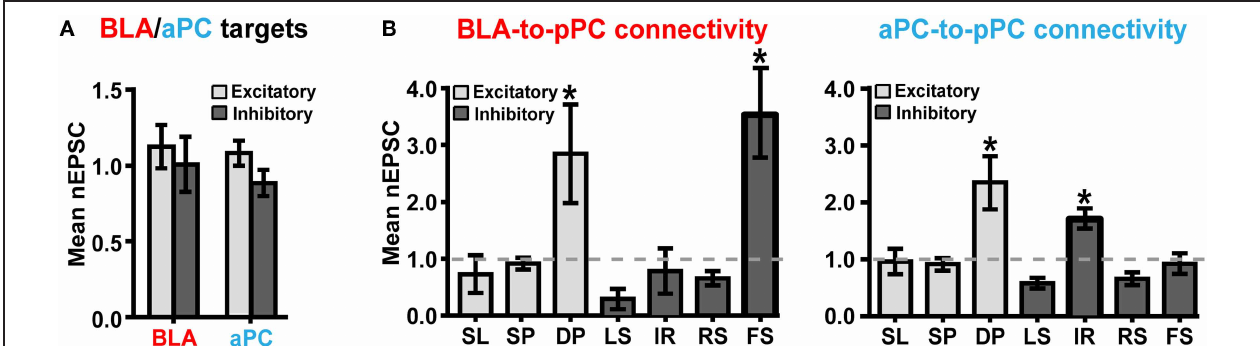
FIGURE 3 | BLA and aPC preferentially recruit DP + FS and DP + IR microcircuits, respectively. (A) Histograms showing that, in general, the strengths of BLA and aPC synaptic connections (or nEPSCs) onto pPC excitatory and inhibitory neurons do not differ. (B) Cumulative nEPSC plots generated from neurons in multiple brain slices. Notice that that the strengths